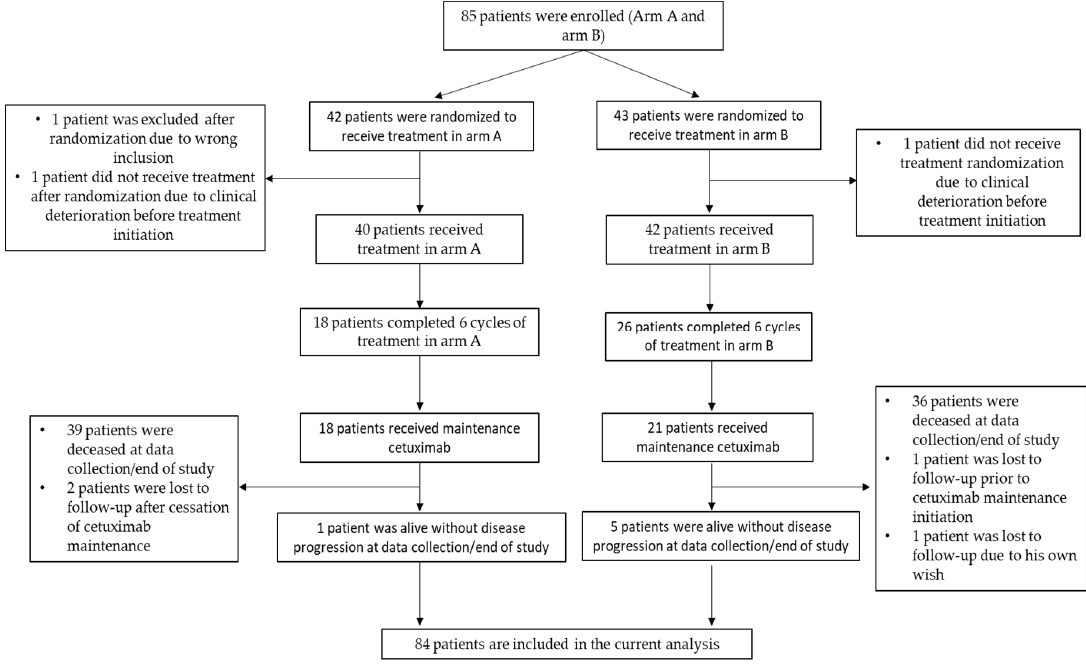
Figure 1. Patient disposition diagram. Table 1. Baseline demographics and disease characteristics.